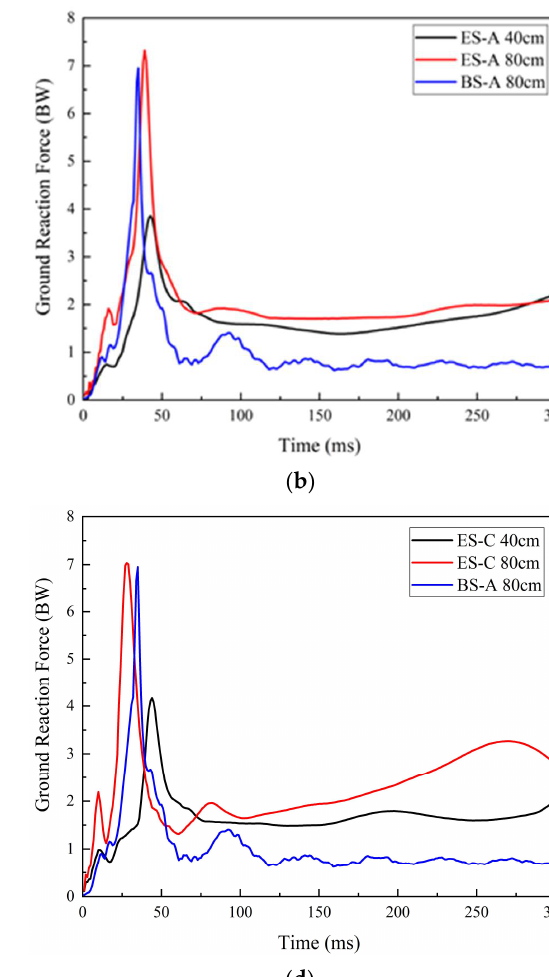
( b ) Figure 9. Results of drop hammer tests at forefoot: ( a ) Gyroid; ( b ) Diamond. 5.3. Drop Landing Test Results In the drop landing tests, five types of shoes were used: Diamond and Gyroid soles with a thickness of 1.5 mm and filled with STF and the Gyroid sole with a thickness of 1.5 mm and no STF filling, with standard paratrooper boots and sports shoes (Under Armour, Baltimore, ML, USA) as a comparison. For convenience, they are named ES-A, ES-B, ES- C, BS-A, and BS-B, respectively. The thicknesses of ES-A, ES-B, ES-C, and BS-A were kept at 37 cm, while the thickness of BS-B was 35 cm. Figure 10 shows representative time history curves of measured vertical GRFs for ES- A, ES-B, ES-C, and BS-B dropped from heights of 40 cm and 80 cm, respectively. For BS- A, considering its actual use condition, only drop landing tests from a height of 80 cm